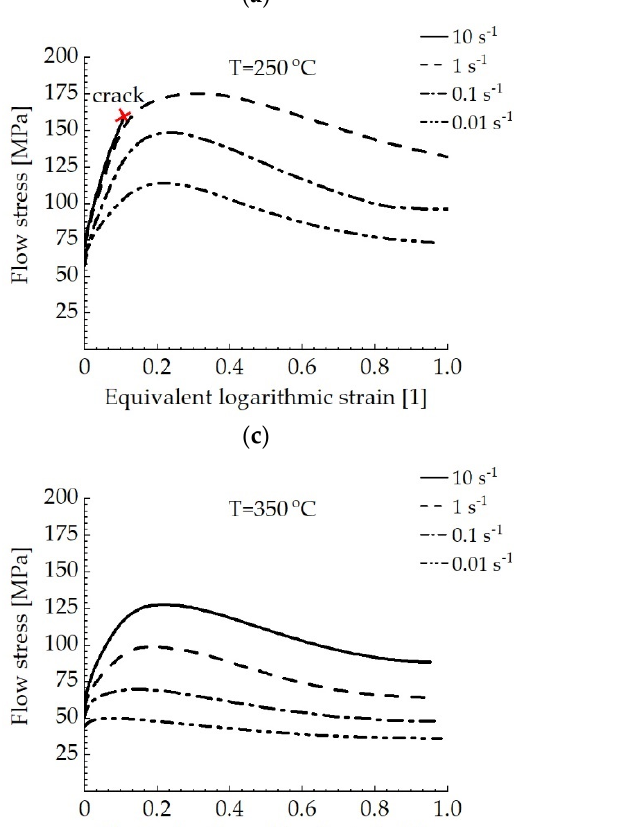
Figure 7. Flow curves of twin-roll cast and heat-treated magnesium alloy AZ31 at different forming speeds and temperatures: (( a ) 250 °C, ( b ) 300 °C, ( c ) 350 °C and ( d ) 400 °C).